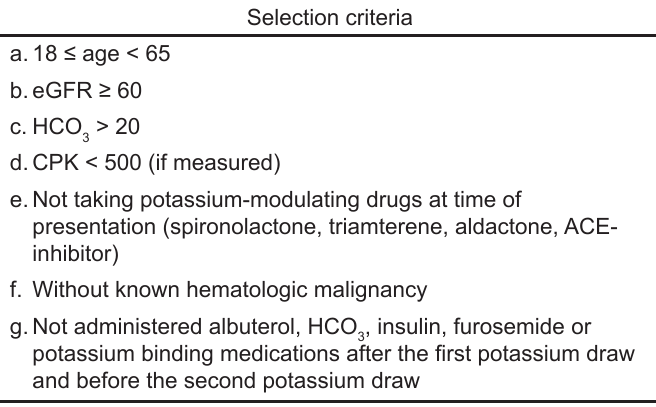
Table 1. Selection criteria to predict the absence of truly elevated potassium levels on repeat blood